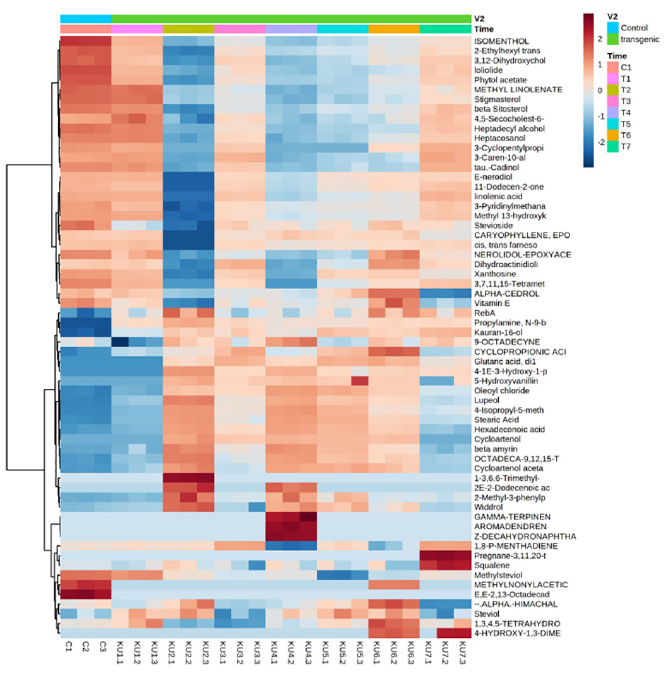
Fig 15. Correlation analysis of the 61 differential metabolites, marked on the hierarchical clustering plot to understand the potential relationships among metabolites.